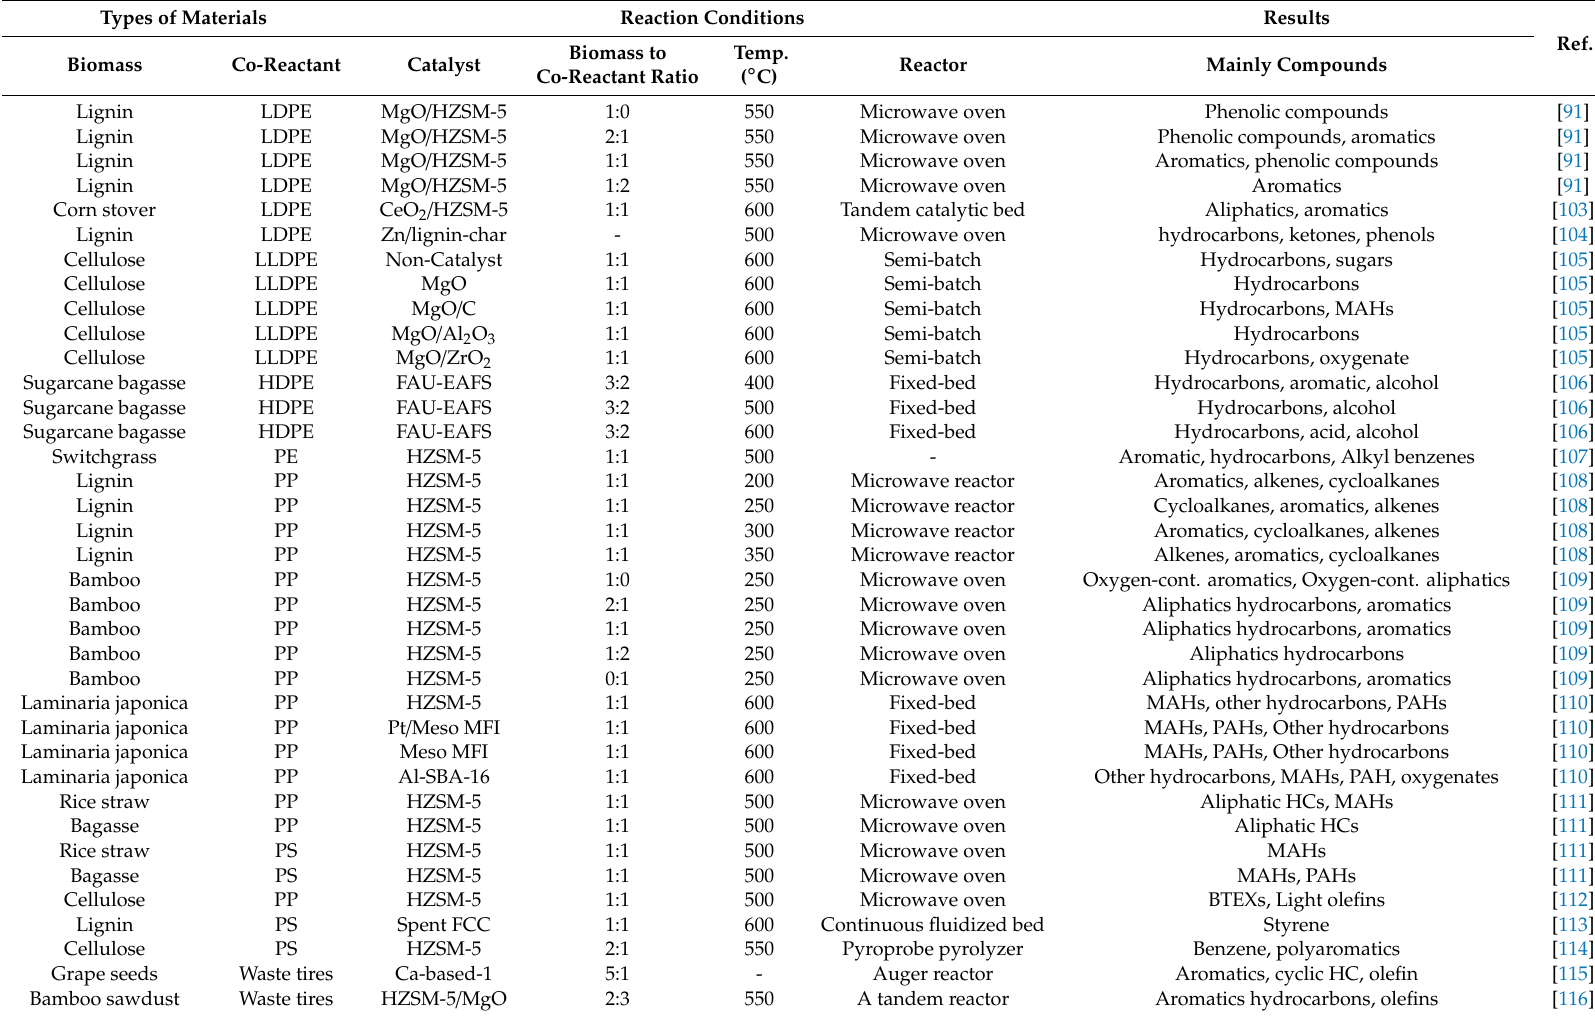
Table 3. Summary of studies on the catalytic co-pyrolysis (CCP) of biomass with hydrogen-rich